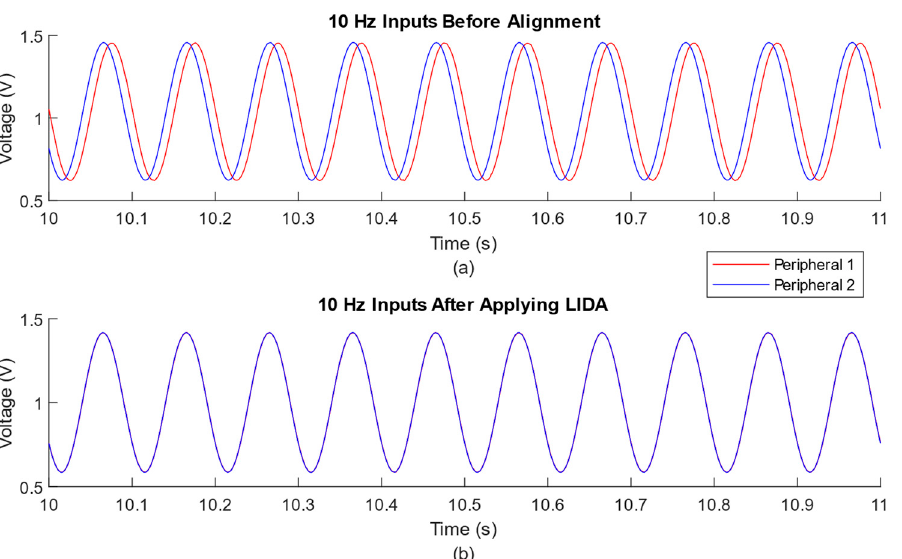
Figure 3. Example time-series plots from one trial (10 s to 11 s time range) of 10 Hz input frequency. ( a ) Input signals from two peripheral nodes without alignment; ( b ) same signals after applying